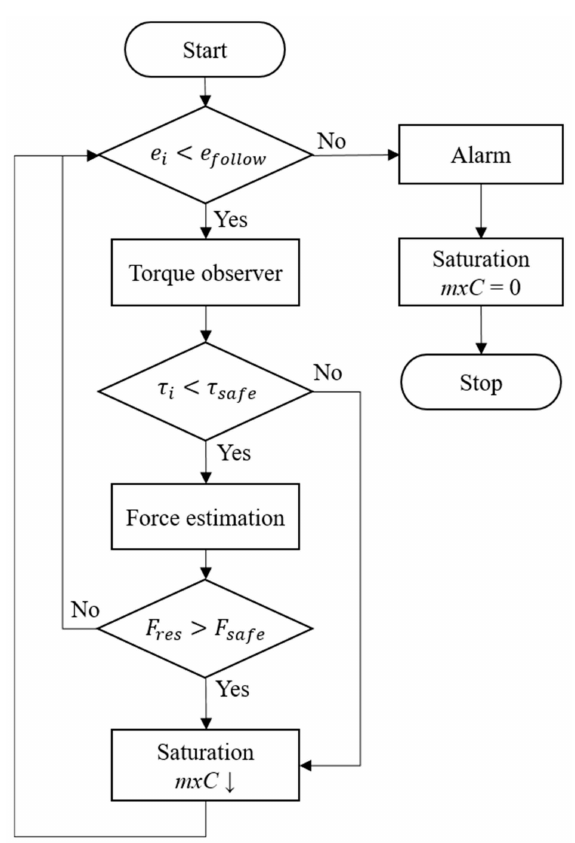
Figure 11. Logical architecture of the force detection and control operations for safety.